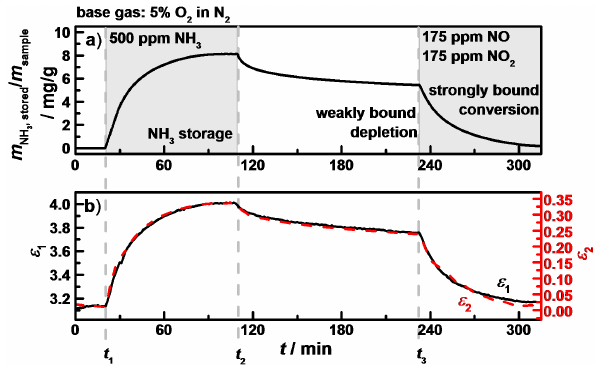
Figure 2. Experimental run for an H-ZSM-5 zeolite with a Si / Al ratio of 27 at 250 ◦ C: (a) the stored amount of ammonia in the sam- ple, and (b) the measured complex dielectric